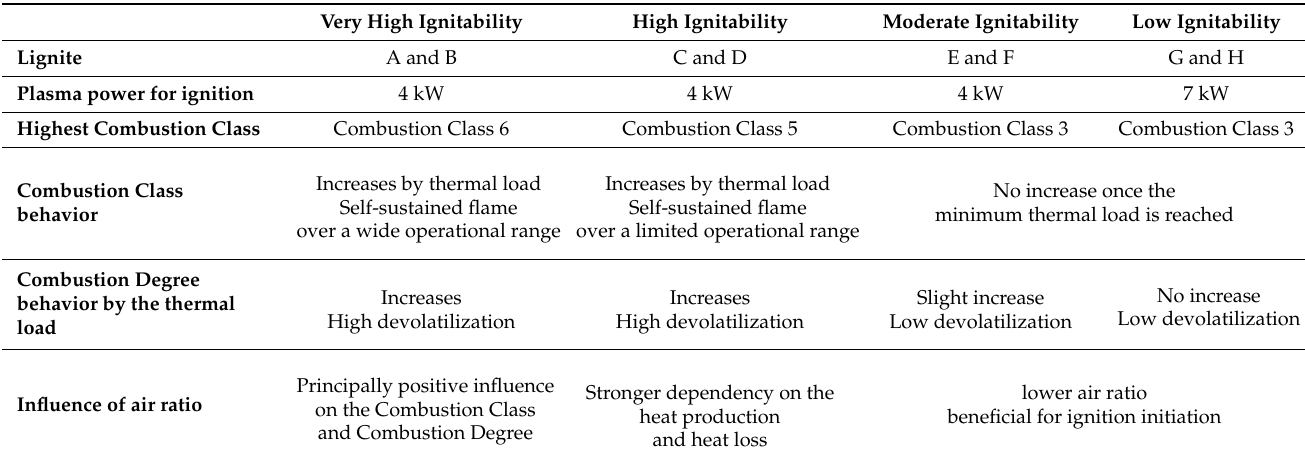
Table 4. Classification of the tested lignite qualities based on the observed behavior in the plasma ignition system for cold